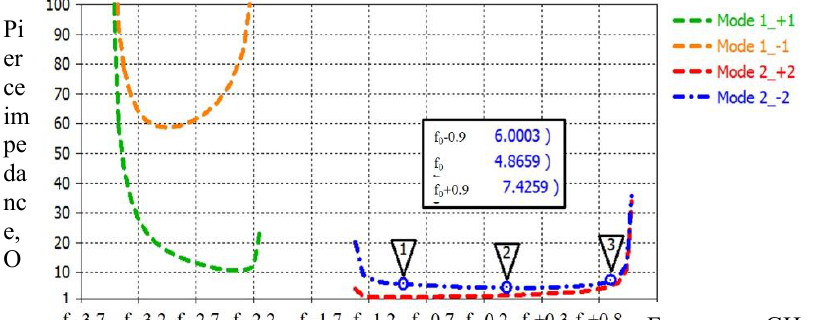
Fig. 3. Frequency response of interaction